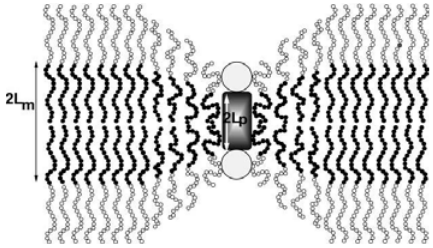
Figure 8. Conformation of polymer chains near an embedded protein in a copolymeric bilayer [62].